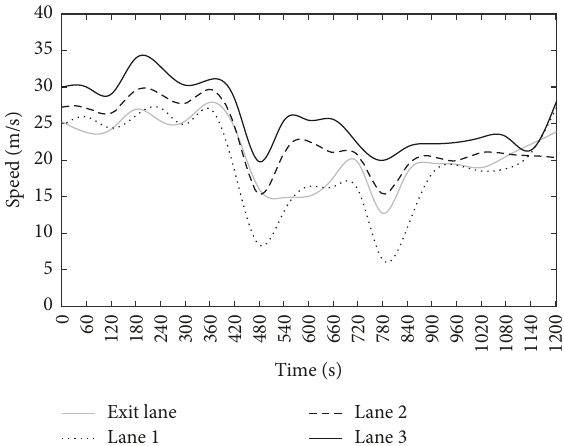
Figure6:Speed-timediagramfortheexitlaneandtheright,middle, and left lane numbered 1, 2, and 3, respectively, above the considered time interval.